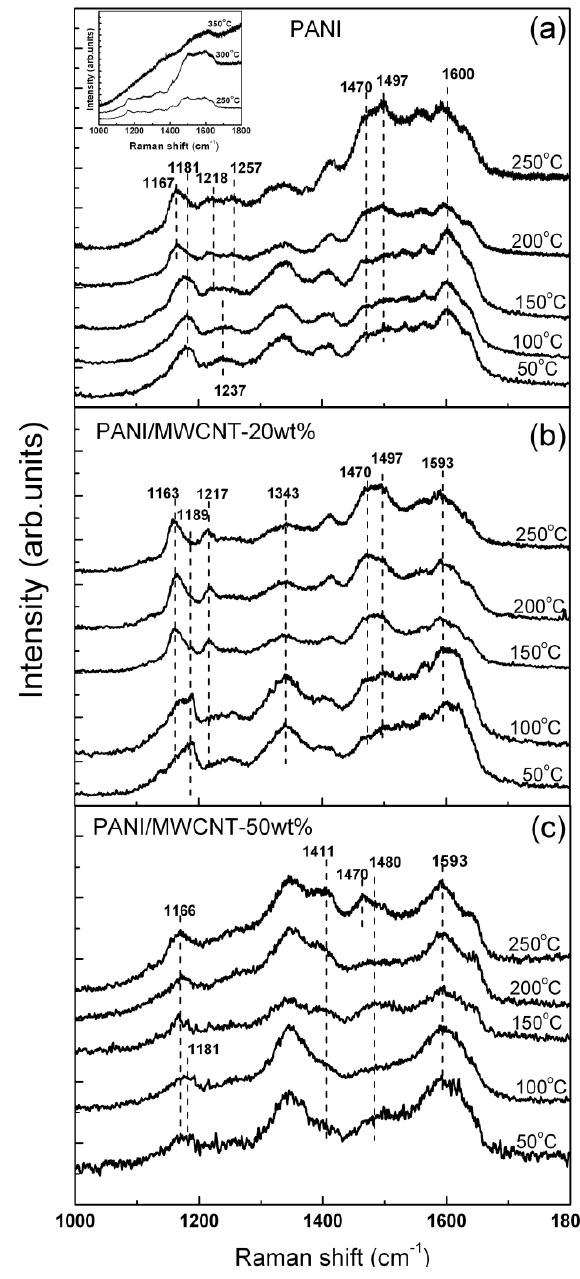
Figure 4. Temperature dependence Raman spectra of ( a ) nf-PANI; ( b ) nf-PANI/MWCNT-20wt%; and ( c ) nf-PANI/MWCNT-50wt% in which the thin films were baked in air before Raman